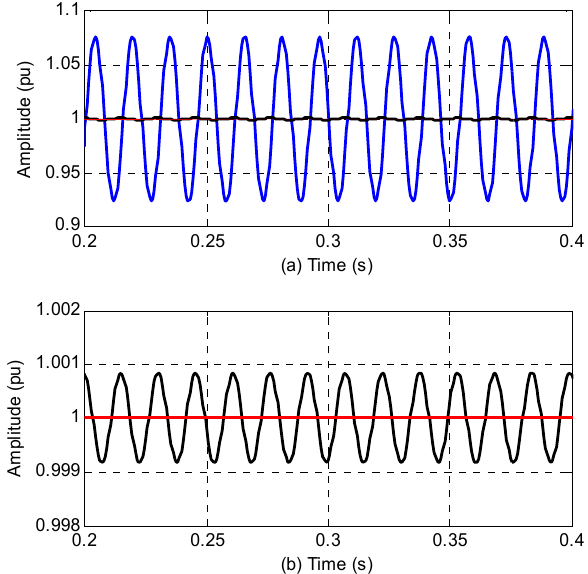
Figure 2. ( a ) Filtering results, and ( b ) a zoomed-in view of filtering results. (The blue line is for the NMAF, the black line is for the LIP-AMAF and the red line is for the FAMAF.).